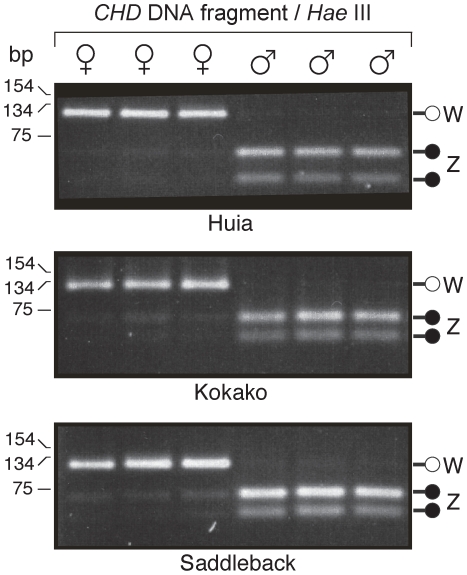
Huia sexing using semi-nested PCR with CHD primers p2/p5 followed by p2/p3.Amplification was followed by digestion of the Z CHD fragment with the restriction enzyme HaeIII. The W chromosome CHD fragment in Huia is 121 bp long and the Z chromosome fragments are 65 and 56 bp in length, after enzyme digestion. Known-sex relatives of Huia, the North Island Kokako and Saddleback, were used to verify the test. Molecular weight maker sizes at shown at left.